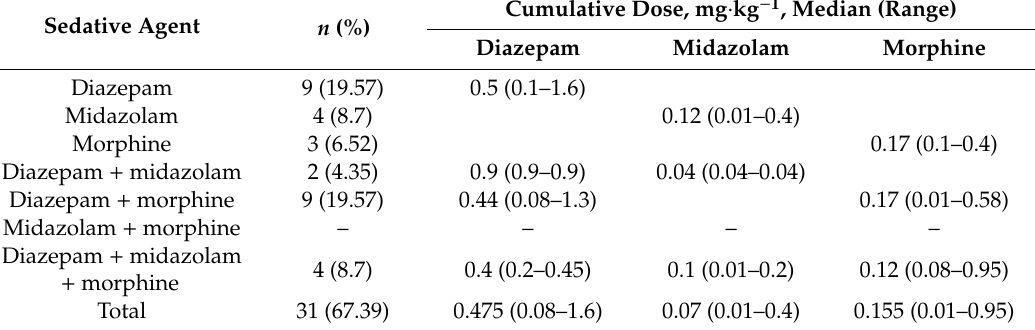
Table 2. The pattern of administration and the cumulative doses of sedative agents given within 24 h before surgery.